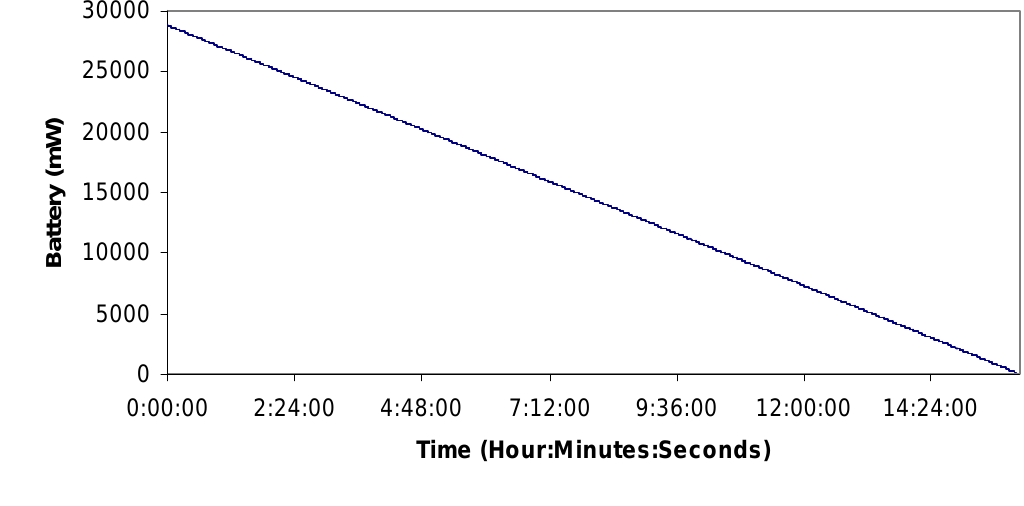
Figure 21. Power consumption in the network because of the packets transmitted and